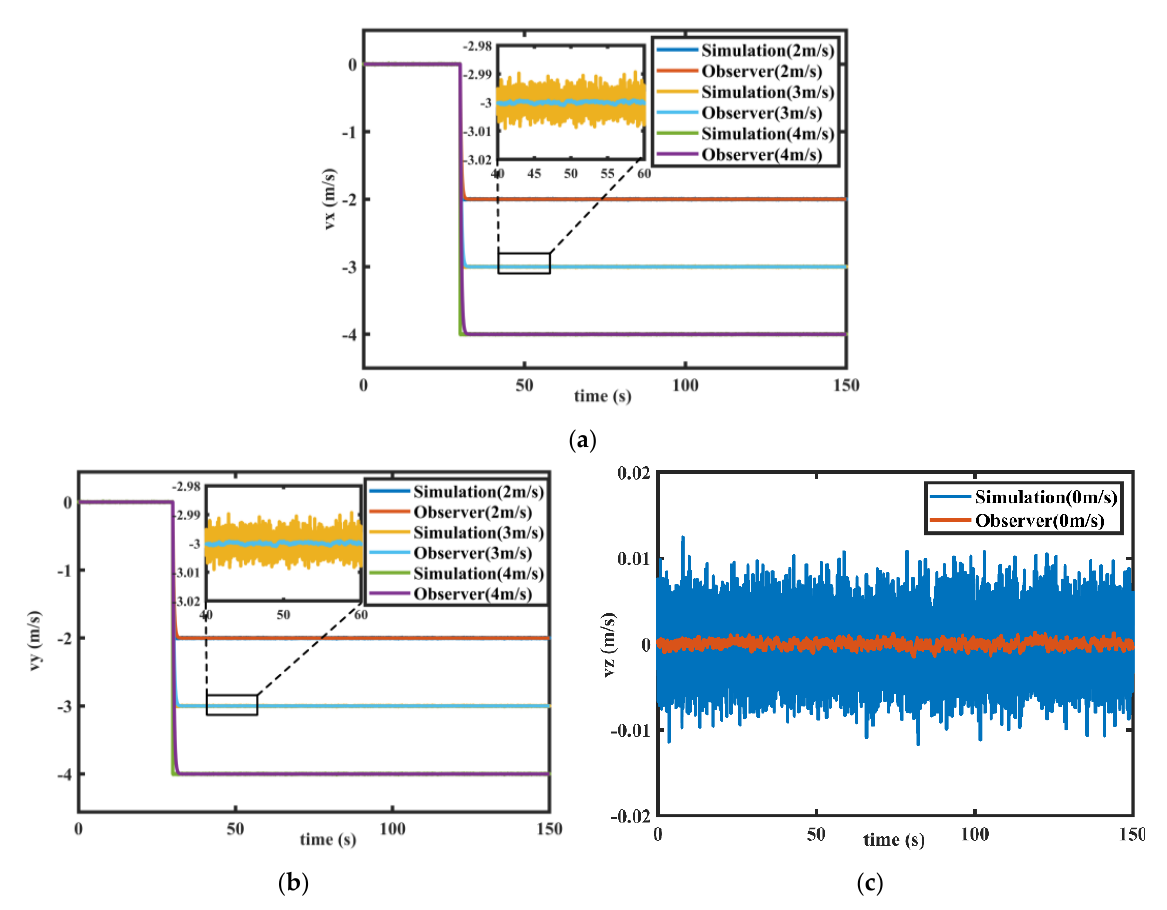
Figure 8. The comparison of ocean current observer estimates with actual currents: ( a ) comparison of real and observed values of ocean currents of different sizes in the X-direction; ( b ) comparison of real and observed values of ocean currents of different sizes in the Y-direction; ( c ) comparison of real and observed values of ocean currents in the Z-direction.